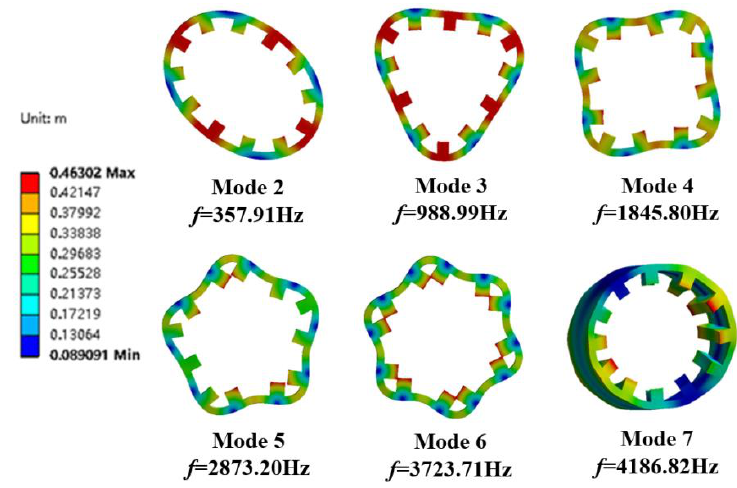
Figure 16. External stator modal analysis cloud diagram.